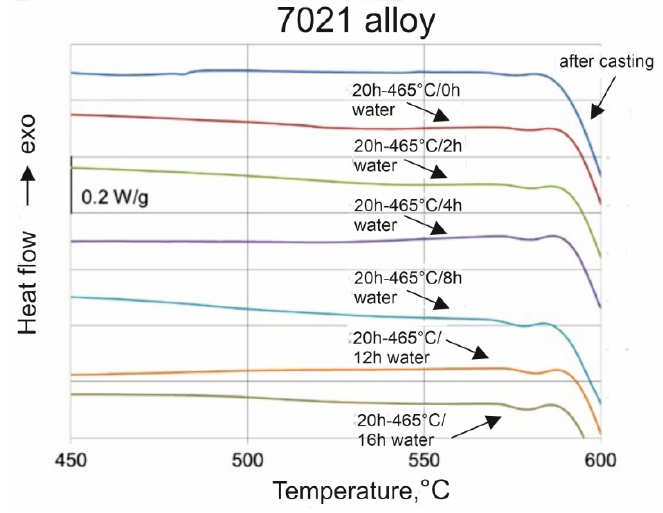
Table 3. DSC test results of homogenized 7021 alloy [22]. Alloy Solidus Temperature, °C